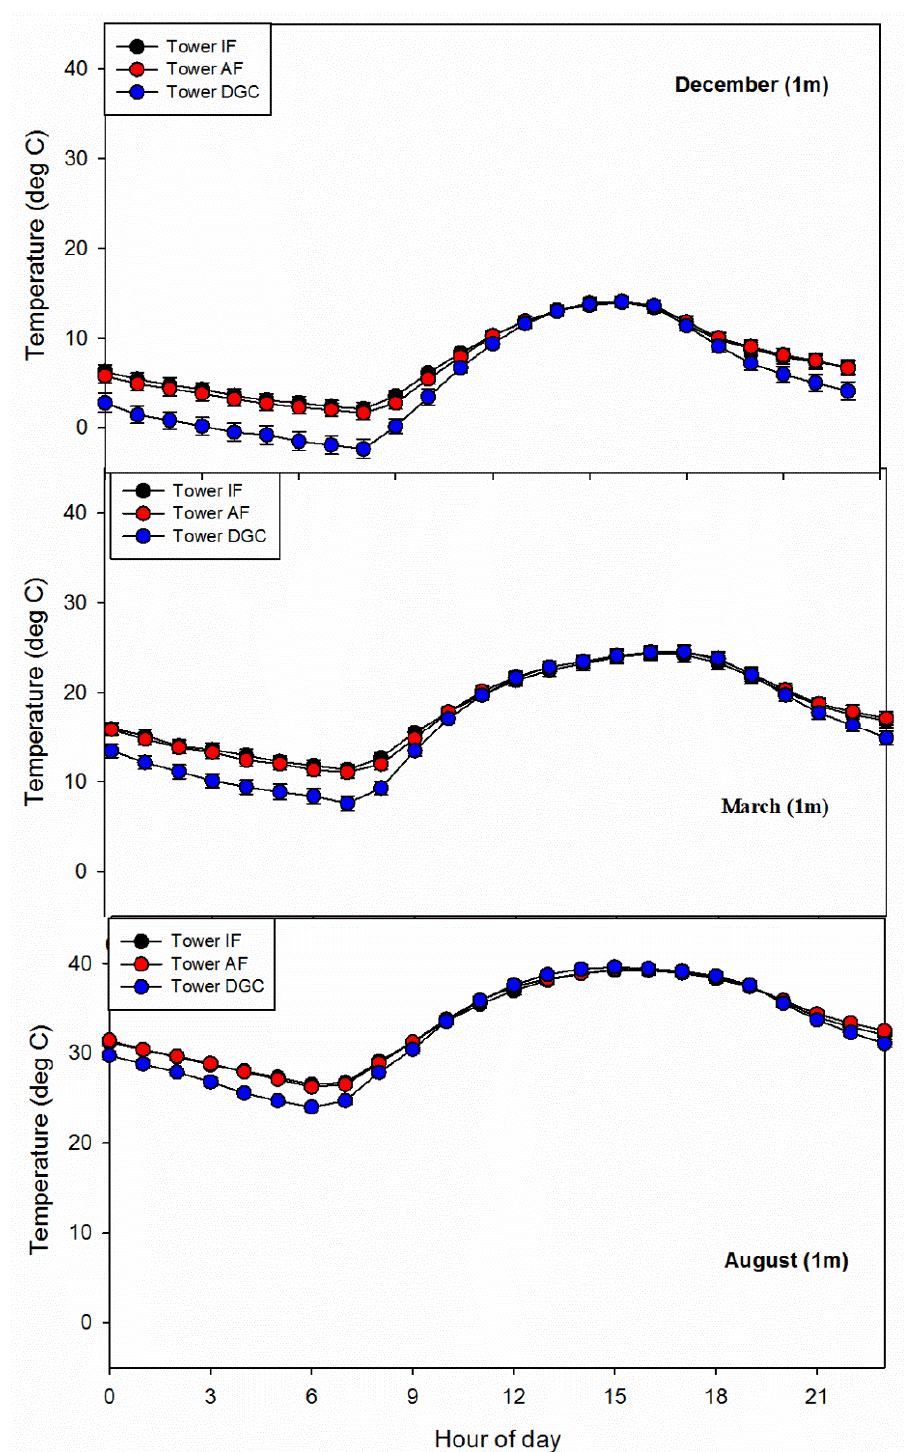
Figure 8. Air temperature hourly average plus error bars for the months of December, March and August 2016 at a height of 1 m at towers IF, AF and DGC.